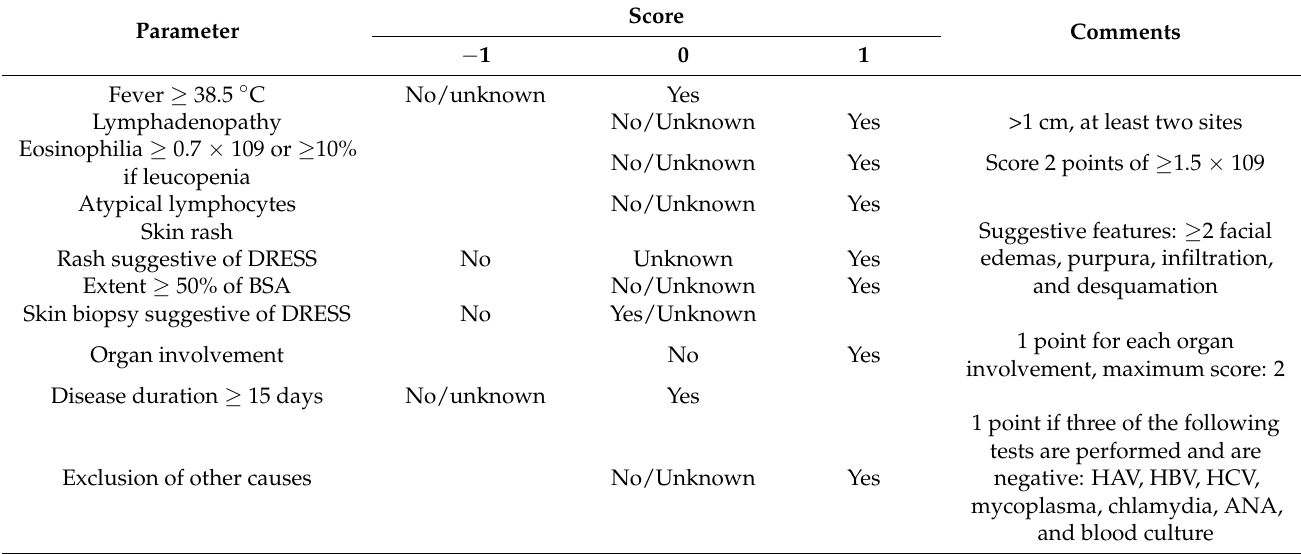
Table 2. RegiSCAR scoring for drug reaction with eosinophilia and systemic symptom syndrome.